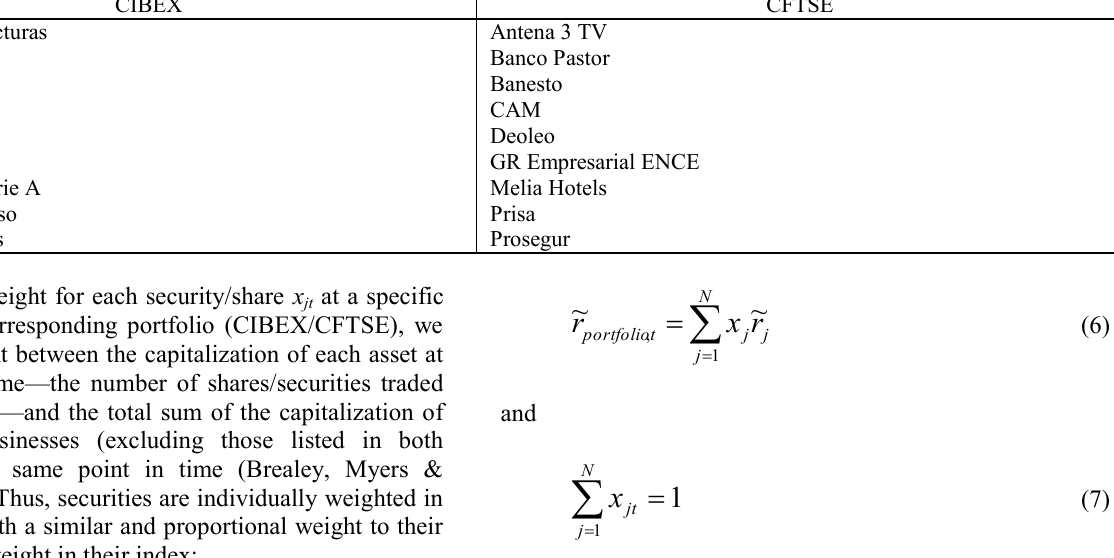
Table 2: Business stocks included in the CIBEX and CFTSE stock portfolios CIBEX CFTSE Abertis